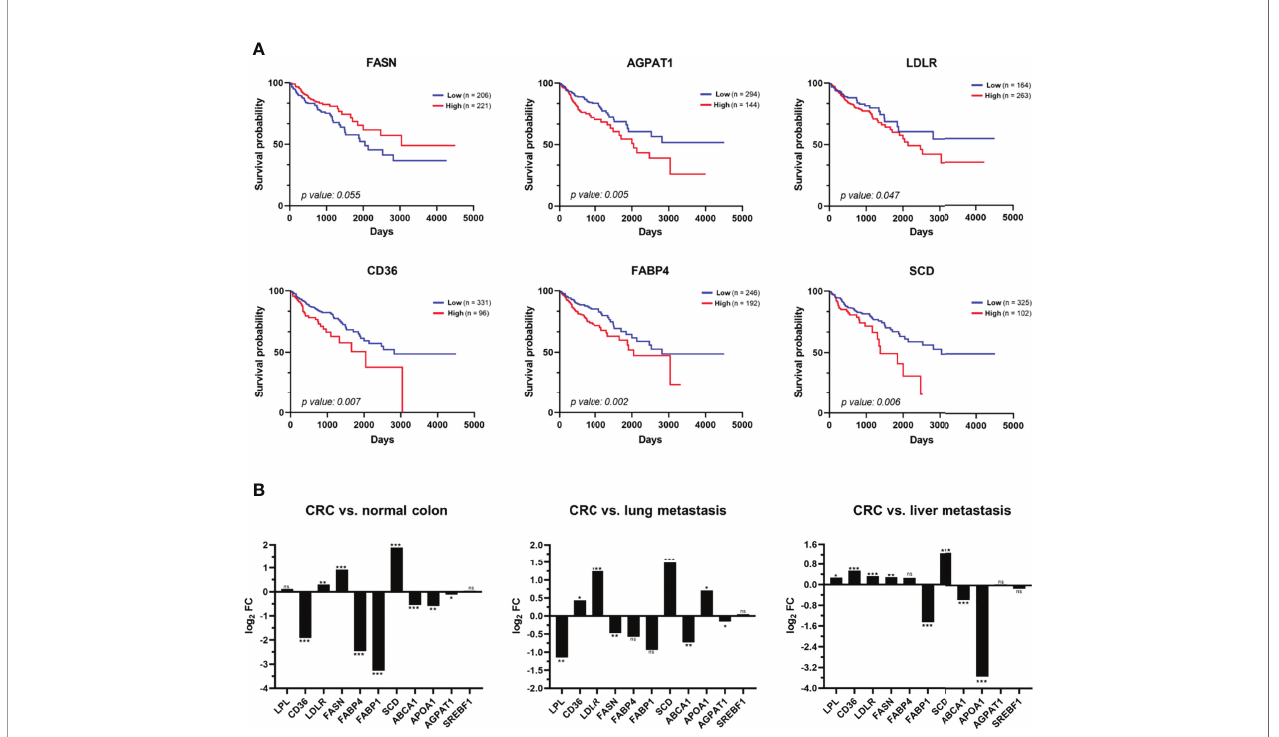
FIGURE 9 | Analysis of the clinical relevance of the metabolic alterations in CRC patients. (A) Meta-analysis of mRNA levels of FASN , AGPAT1 , LDLR , CD36 , FABP4 , and SCD in tissue samples of CRC patients using TCGA data related to colon adenocarcinoma (COAD). Kaplan – Meier analyses of overall survival of patients with colon cancer showed that a high expression of AGPAT1 , LDLR , CD36 , FABP4 , and SCD are prognostic factors of worst prognosis for CRC patients. (B) The dataset from the NCBI Gene Expression Omnibus GSE68468 was used to analyse 47 metastatic samples to the liver and 20 metastatic samples to the lung from patients with primary colon cancer in comparison to 186 CRC primary tumour samples and 55 normal colon samples. Box-plots in log 2 revealed a dysregulation of nine of the 11 proteins analysed in CRC primary tumour in comparison with normal colon mucosa (left panel). In addition, a statistically signi fi cant upregulation of LPL , FASN , AGPAT1 , and ABCA1 in lung metastasis in comparison with primary CRC tumour (middle panel) was found, whereas FABP1 , ABCA1 , and APOA1 were found statistically upregulated in liver metastasis in comparison with primary CRC tumour (right panel). FC, fold change; ns, not-signi fi cant; * p value < 0.05; ** p value < 0.01; *** p value <